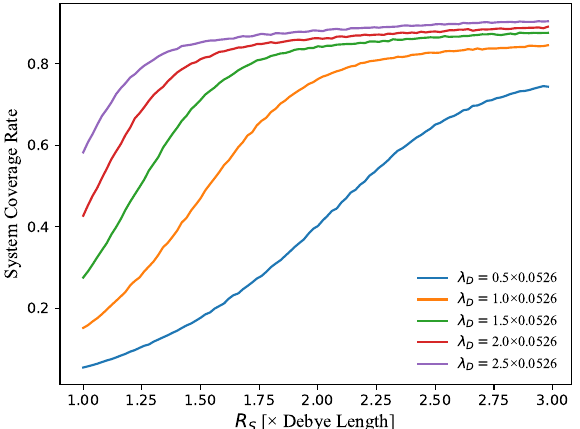
Figure 8. The changes of the final system coverage rate at 3000 time steps developed by our 3D algorithm as a function of node sensing radius R S , corresponding to different values of λ D